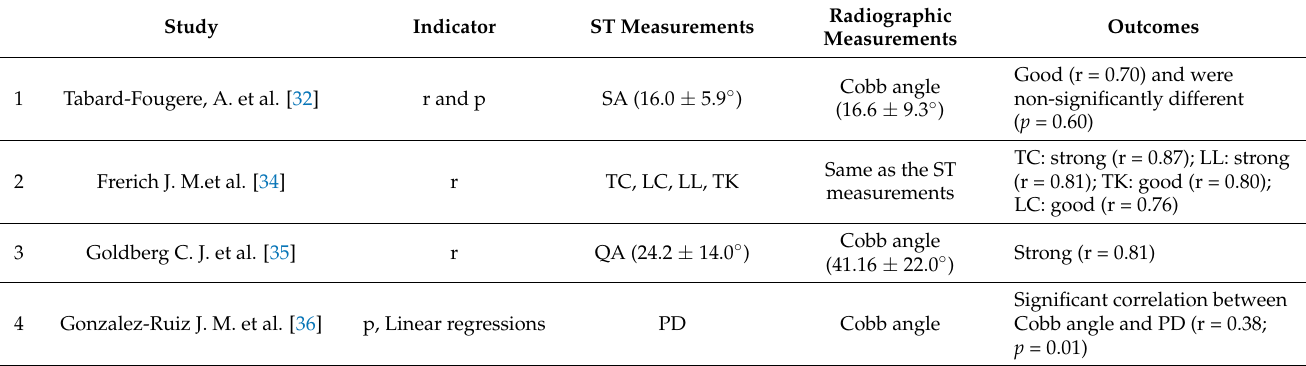
Table 8. Validity